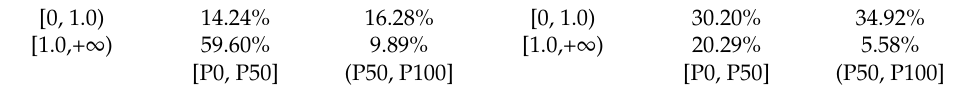
Table 4. Comparison of statistics from two tables (links: Table 2; right: Table